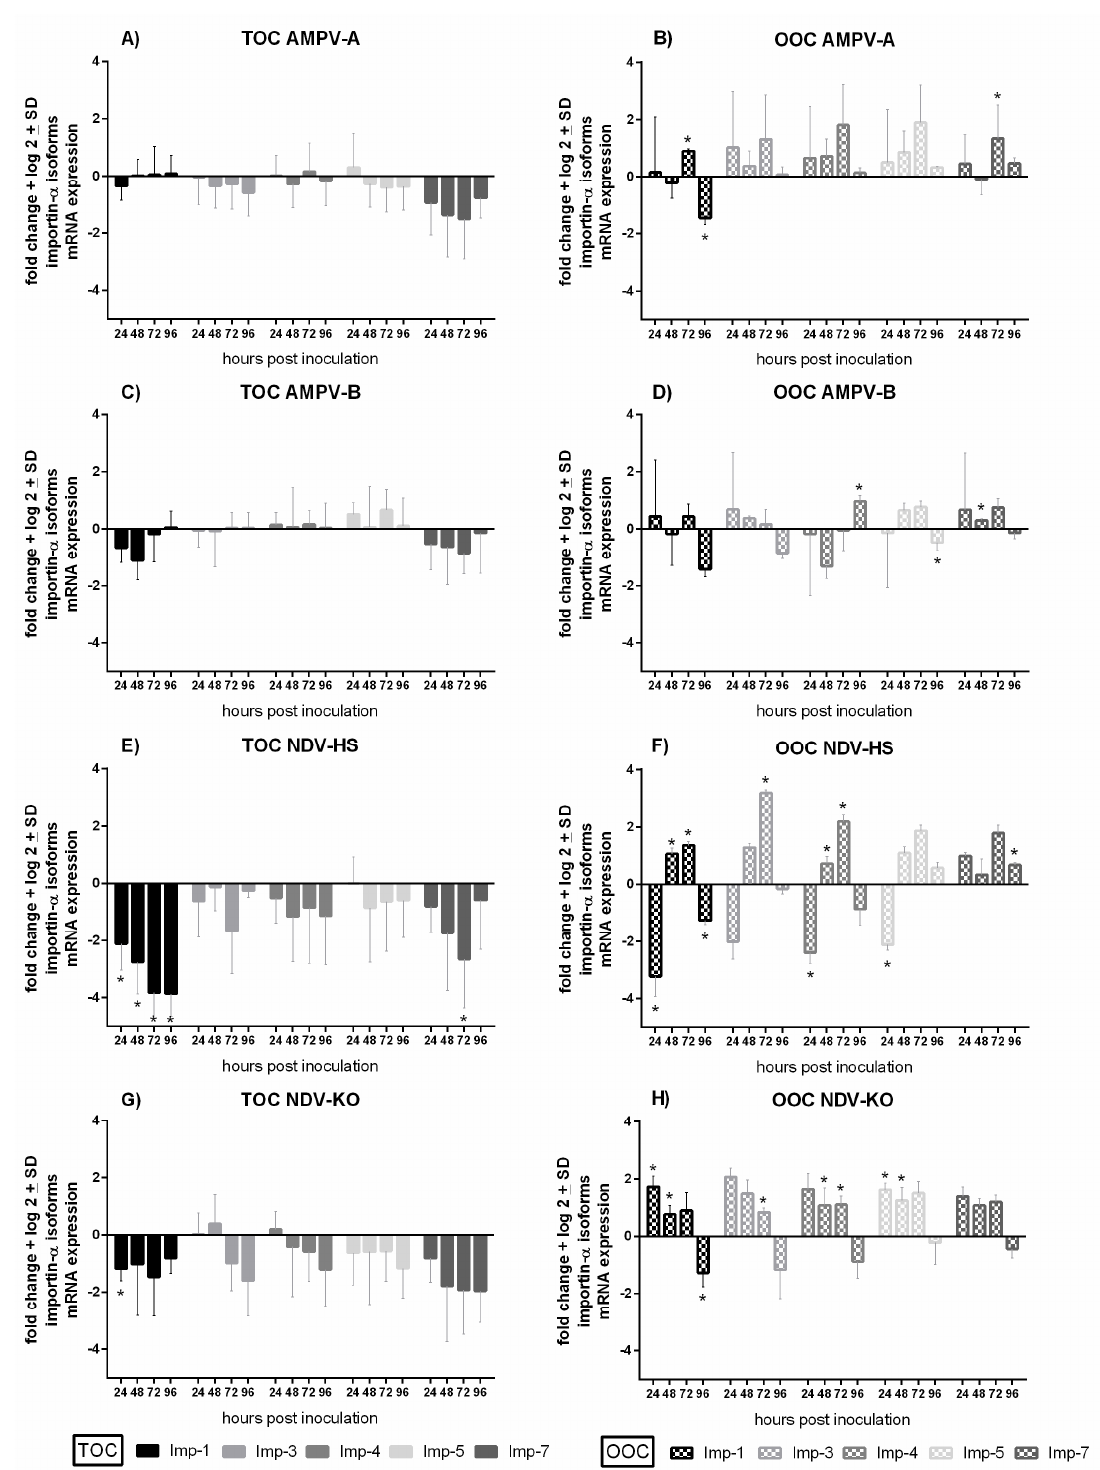
Figure 8. Quantification of mRNA expression levels of importin- α isoforms in TOCs and OOCs after infection with AMPV or NDV. The different mRNA expression patterns of importin- α 1, 3, 4, 5, and 7 were detected after the infection of TOCs ( A , C , E , G ) and OOCs ( B , D , F , H ) with either ( A , B ) AMPV-A, ( C , D ) AMPV-B, ( E , F ) NDV-HS, or ( G , H ) NDV-KO. * indicate significant differences between the virus-inoculated group and the virus-free group at the same time point, determined using the Tukey HSD all-pairwise comparison test (ANOVA p < 0.05). The graphs represent data from one representative experiment.